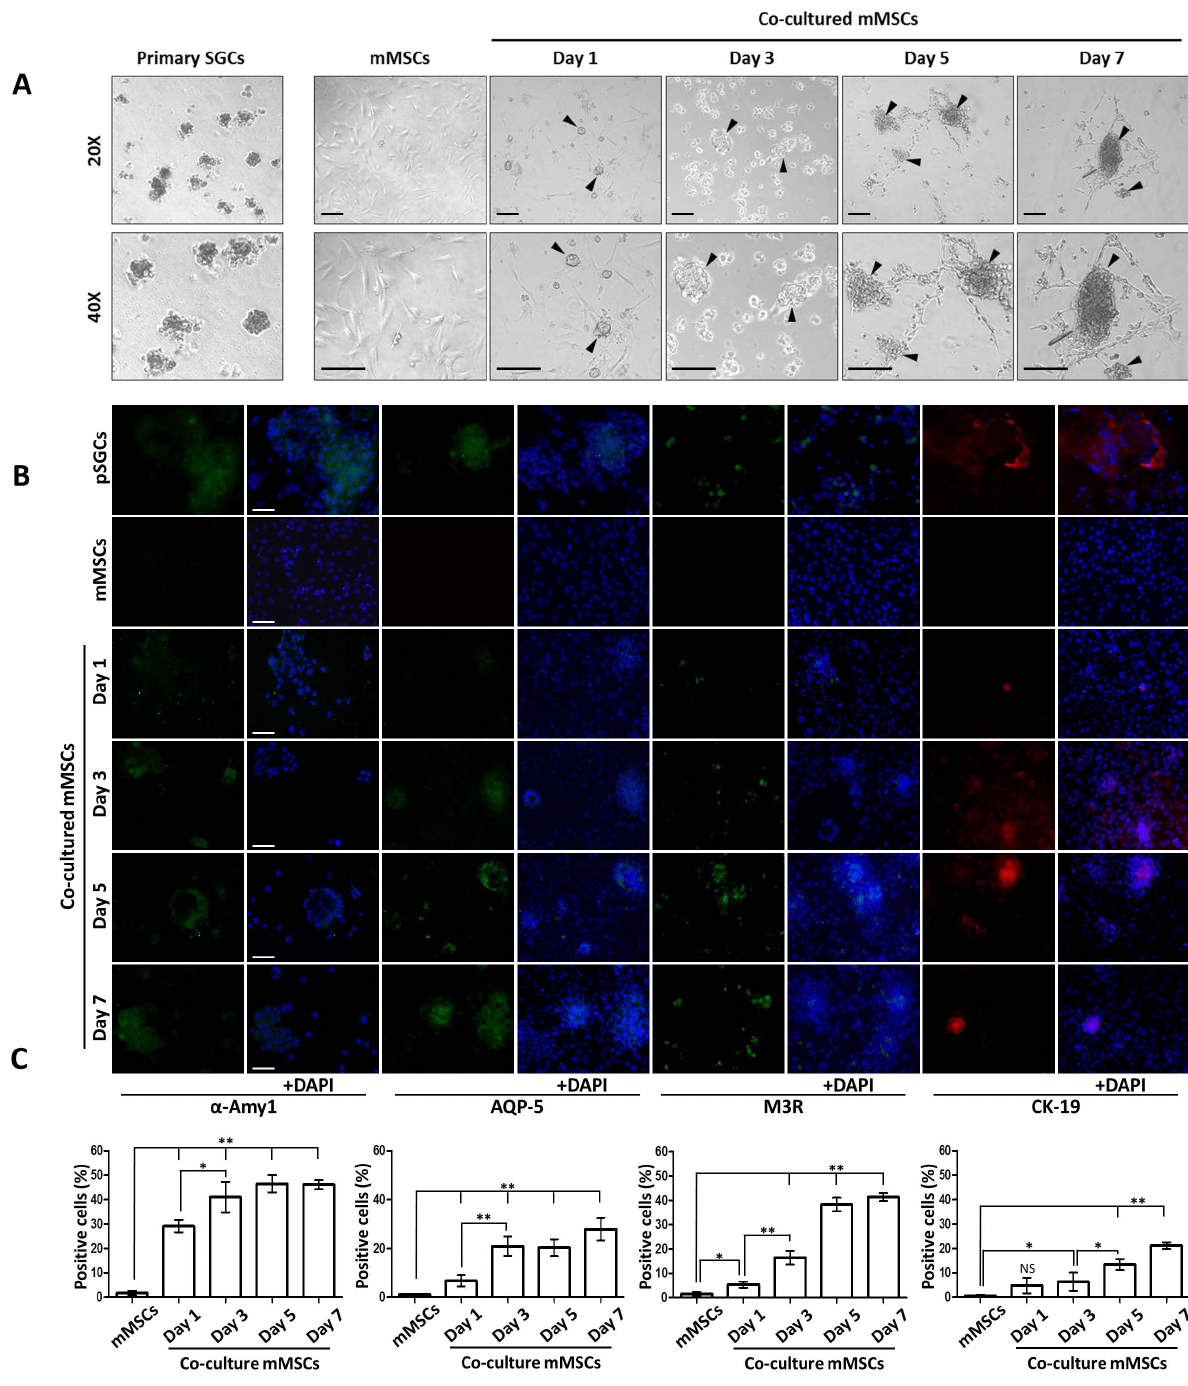
Figure 1. Co-cultured mMSCs resemble primary salivary gland cell morphology and express salivary gland epithelial cell markers. A) Microscope images (at 20X and 40X magnifications) of pSGCs from C57BL/6 mice (first panel), control mMSCs (second panel), and co-cultured mMSCs with pSGCs were shown. Mouse pSGCs showed islet-like cell morphology whereas control mMSCs exhibit typical fibroblast-like appearance. Aggregated cell masses, which resemble islet-like pSGCs, at each time point were indicated by black arrowheads. Co-culture was carried out for 7 days without replacing media. B) Co-cultured mMSCs were positively stained for acinar cell markers, such as a-amylase, and M3R (green color in each column) in a time dependent manner and a ductal cell marker CK19 (red color). Control mMSCs (second row) were negative while cytospinned pSGCs (first row) from the submandibular glands were positive for these markers. The nuclei were stained with DAPI and the column of + DAPI indicates merged images. Scale Bar=50 m m. C) Co-cultured mMSCs were counted from four independent biological replicates after staining using a fluorescent microscope. Y-axis represents a percentage of positively stained mMSCs for each marker protein at a given time point. Pictures were taken at a 20X magnification. Quantification of cell numbers over time was performed by one-way ANOVA with Bonferroni post-hoc test (*p , 0.05, **p , 0.01, NS: no significant).